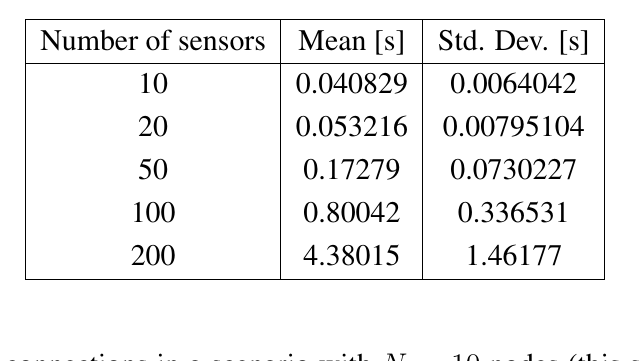
Figure 1. Pairwise connections in a scenario with N = 10 nodes (this scenario will corre- spond to that in Figure 4a). Two values for the total network transmit power are considered: (a) P = 5 · 10 − 5 W and (b) P = 2 . 5 · 10 − 5 W. In both cases, the proposed tot tot